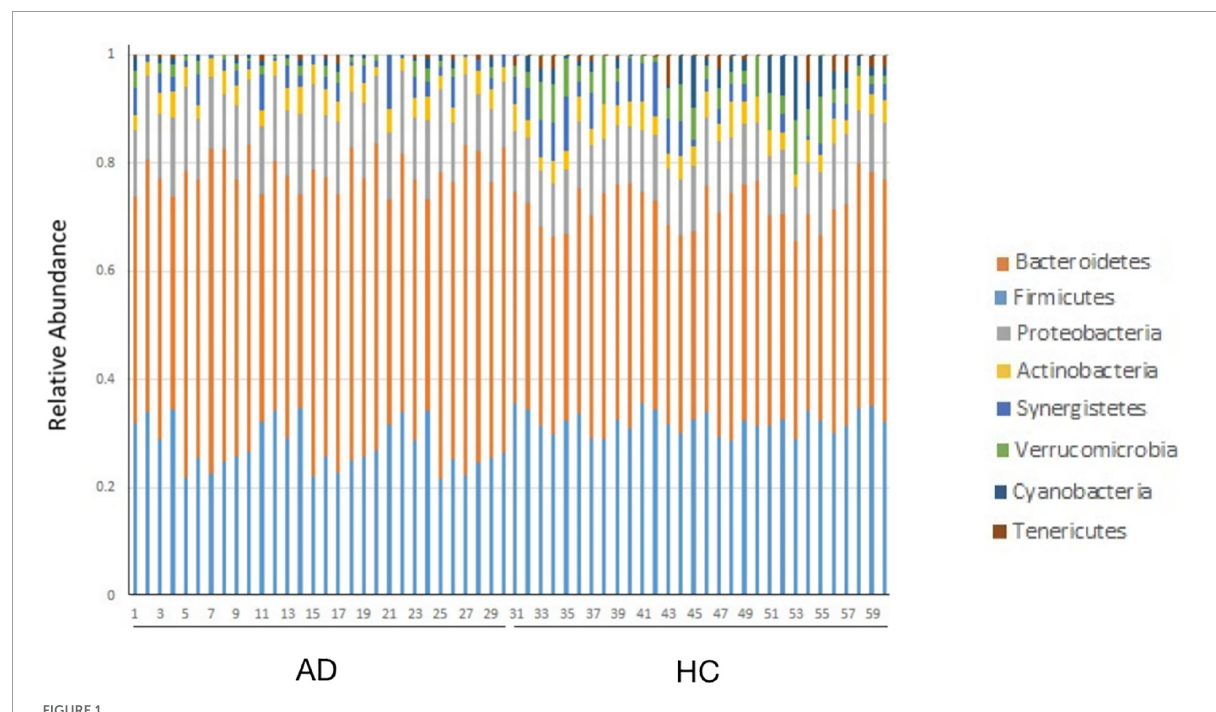
FIGURE1 The bacterial community structure of the two groups of samples at the phylum level.